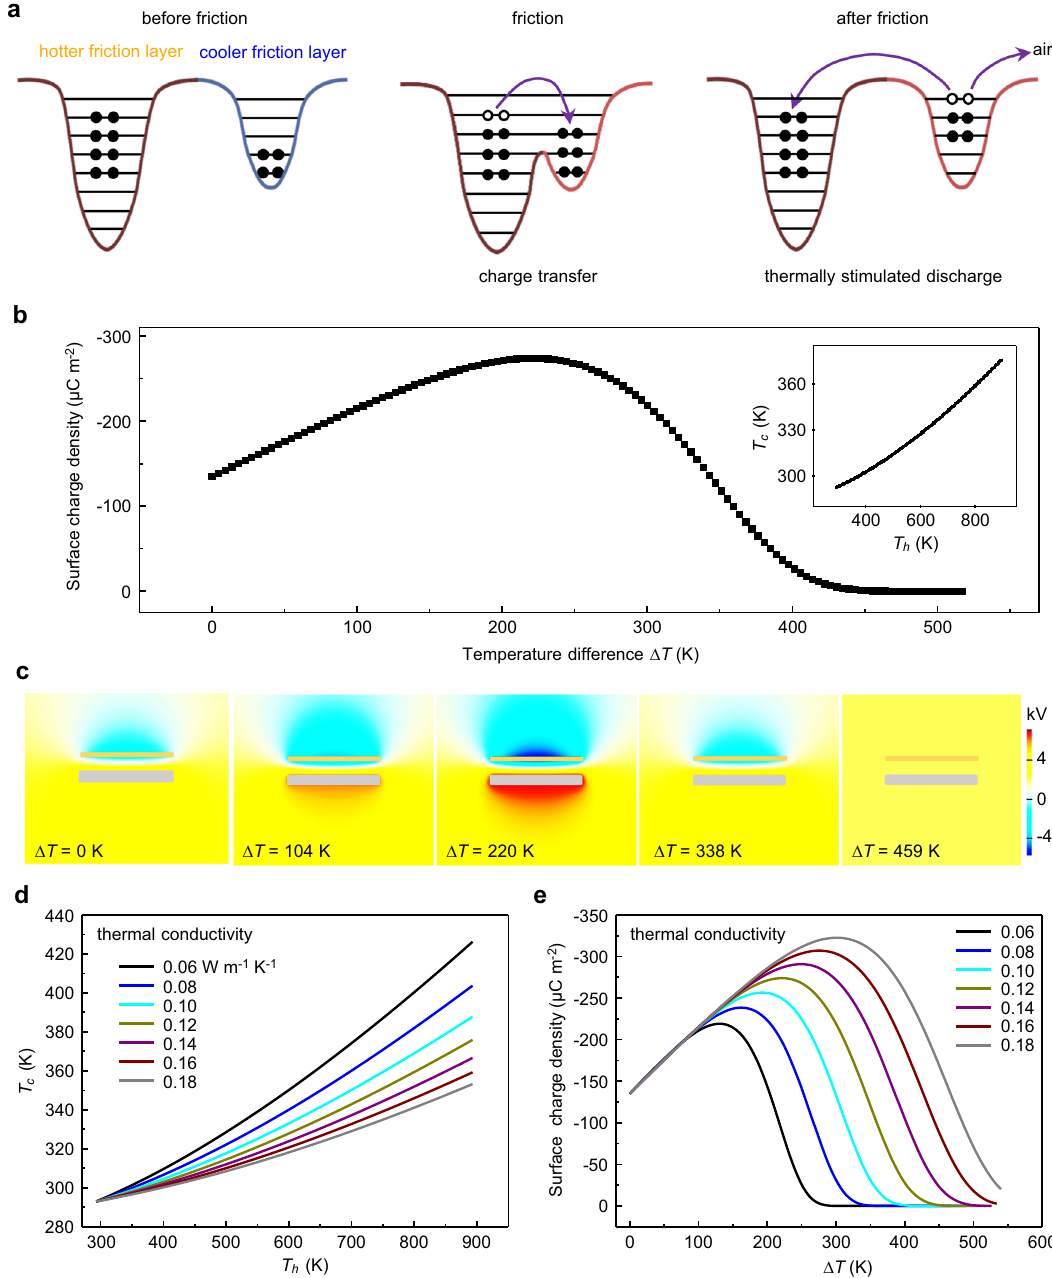
Fig. 1 The in fl uence of the temperature difference between different friction layers Δ T on the performance of triboelectric nanogenerator (TENG). a Effect of Δ T on charge transfer and dissipation. The black dots represent the electrons, and the black lines represent different energy levels. The brown, blue, and red curve represent the potential wells of different friction layers, respectively. b Numerical simulations of the relationship between Δ T and the short-circuit transfer charge density. The relationship between the temperature of the hotter friction layer ( T h ) and the temperature of the cooler friction layer ( T c ) is shown in the inset. c The potential distribution of TENG under different Δ T . d The in fl uence of the thermal conductivity of the cooler friction layer on T c . e The in fl uence of the thermal conductivity of the cooler friction layer on the surface charge density of the cooler friction